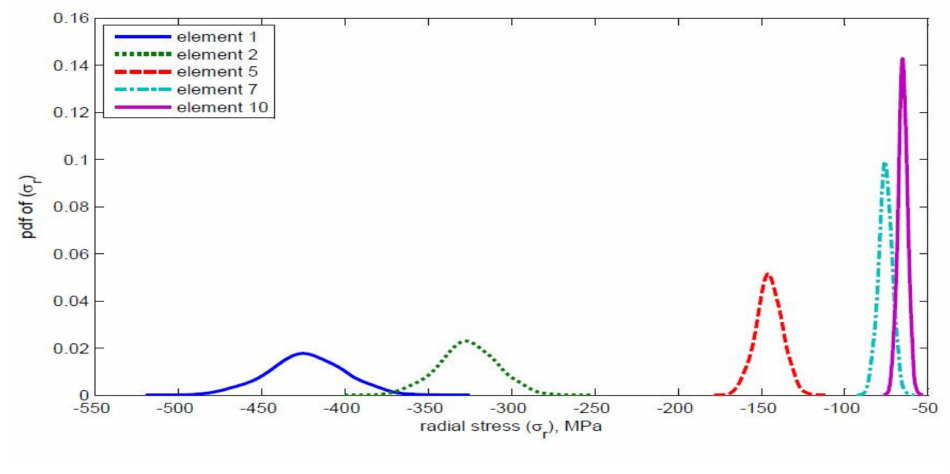
Figure 17. Comparison of axial stress and von Mises stress for different elements when E is a random variable.